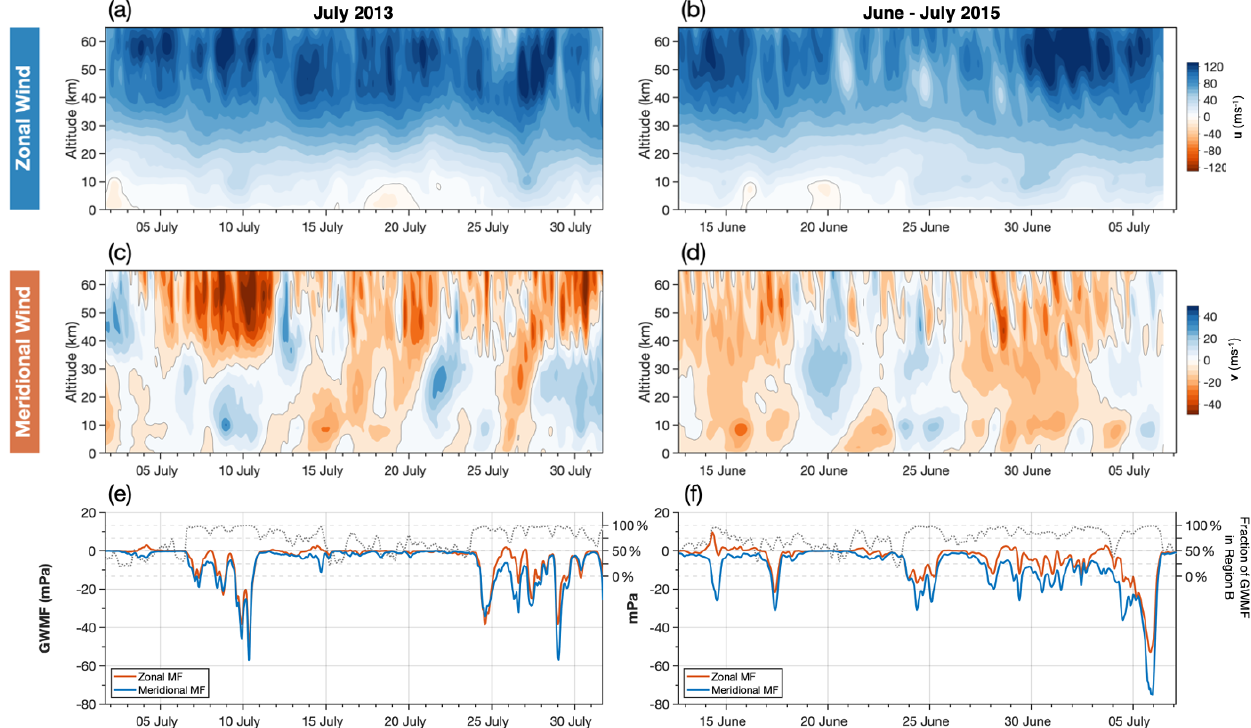
Figure 2. Hourly zonal and meridional wind speeds against altitude in the local-area model over South Georgia during July 2013 (a, c) and June–July 2015 (b, d) averaged over a horizontal region 600km × 400km centred on the island (region C in Fig. 4). Panels (e, f) show average zonal (blue) and meridional (orange) gravity wave momentum fluxes (GWMFs) ρ between 25 and 45km altitude. Positive (negative) values indicate eastward (westward) zonal GWMF and northward (southward) meridional GWMF. Dotted lines in (e, f) show the percentage of the total model GWMF (right axis) downwind of the island (region B in Fig. 4), which is a strong indication of mountain wave